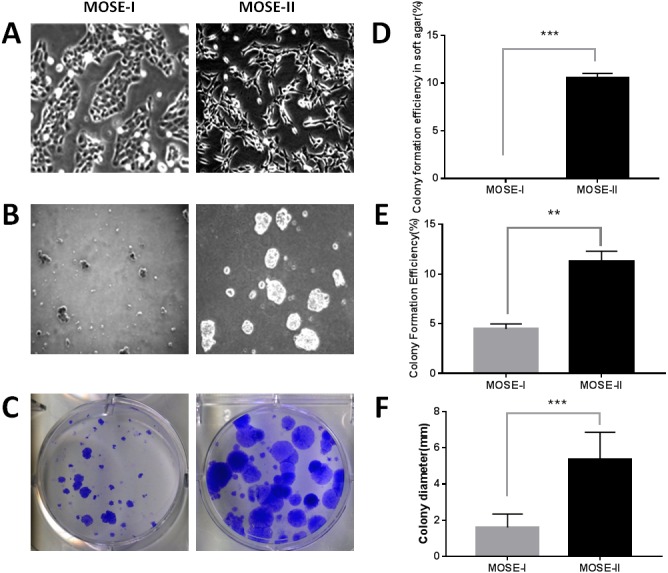
Characterization of MOSE-I and MOSE-II cells in vitro.(A) Bright-field inverted microscopy. Cells were grown at Passage 20 for MOSE-I and Passage 90 for MOSE-II and then photographed at a magnification of 100×. (B) The soft agar colony formation assay. MOSE-I (passage 20) and MOSE-II (passage 90) were grown in the soft agar for 7 days and photographed. (C) The plate colony formation assay. MOSE-I (passage 20) and MOSE-II (passage 90) were grown for 14 days and stained with crystal violet solution and photographed. The graphs were quantified data of the colony formation assay. ∗∗p < 0.01 and ∗∗∗p < 0.0001 analyzed by Student’s t test. The data on E and D were generated by the Image J software, while the data on F were from the EVOS XL imaging system.